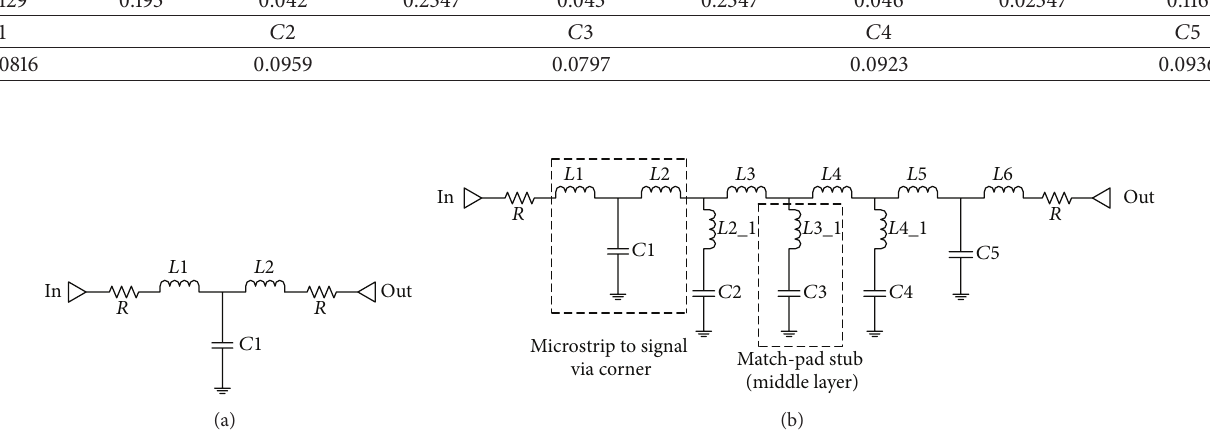
Figure 3: The physics-based equivalent circuit of the vertical via transition. (a) The T-type circuit for microstrip-to-vertical-signal-via corner; (b) the entire circuit for 3D transition structure.